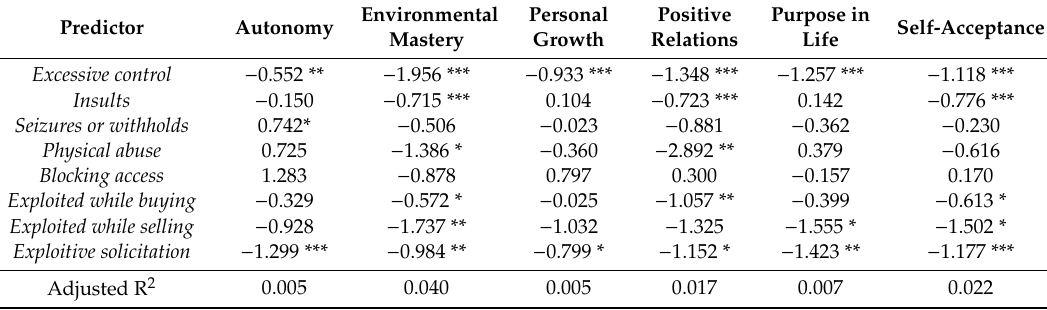
Table 5. OLS regression models with elder mistreatment predicting psychological well-being 1 . Predictor